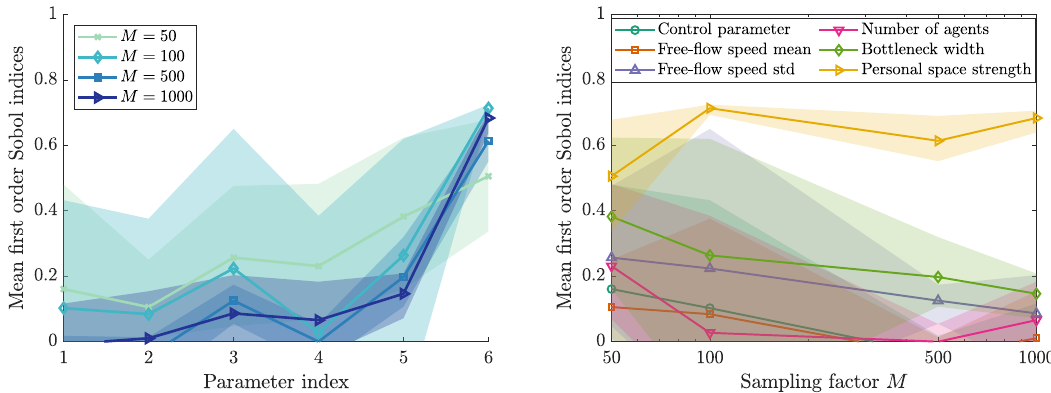
Figure 6. Sobol’ first order indices for our bottleneck scenario. Calculated with Monte Carlo approach using Saltelli’s method [52]. For each sampling factor M , 3 runs were performed. The parameter index is mapped as follows: 1—control parameter, 2—free-flow speed mean, 3—free-flow speed standard deviation, 4 —number of agents, 5—bottleneck width, and 6—personal space